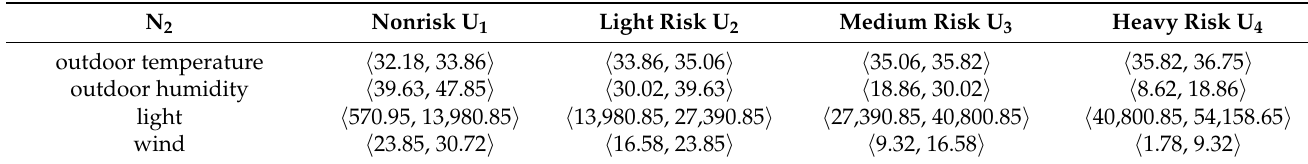
Table 5. Classical field of outdoor meteorological indexes (N 2